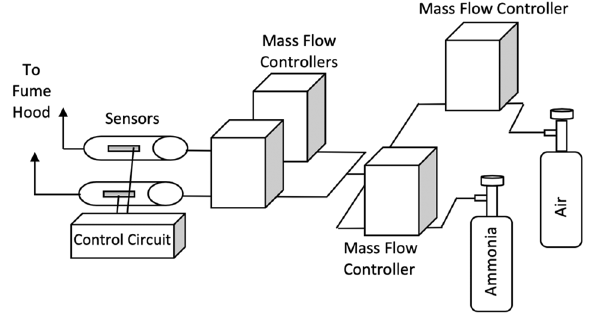
Figure 7. Schematic of apparatus used for the detection of